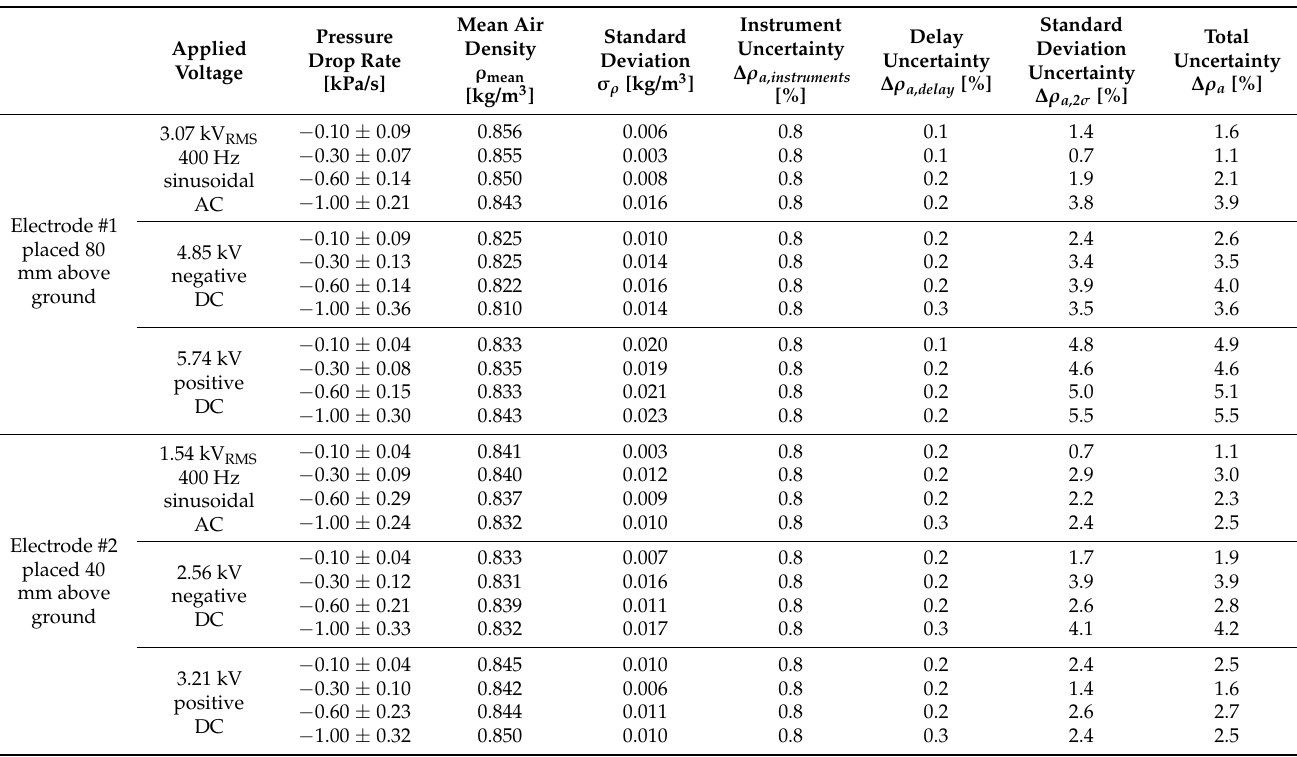
Table 2. Dynamic pressure tests made with the two electrodes performed at constant voltage and applying different types of voltage at different pressure drop rates.